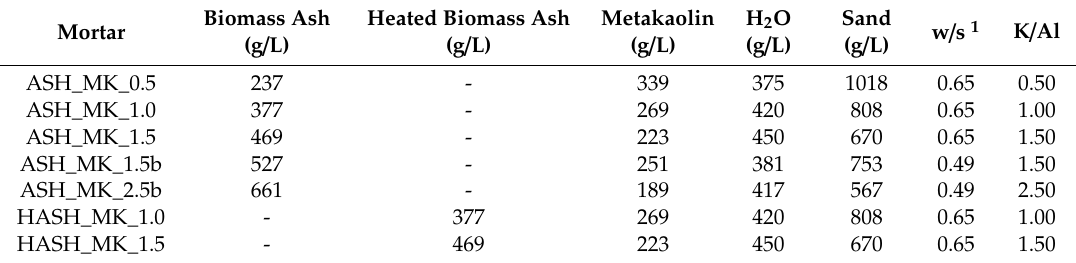
Table 4. One-part alkali-activated mortars composition (g /